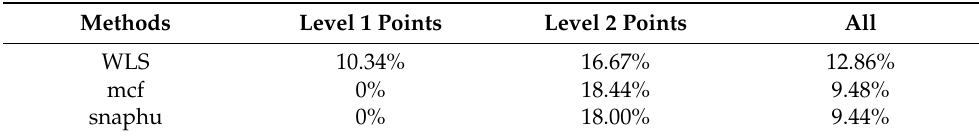
Figure 6. Comparison of unwrapping errors of different methods. Letters a, b, and c represent the WLS, mcf, and snaphu methods, respectively. Numbers 1–6 represent the unwrapping error of the first-level phase points without hierarchical networking, the unwrapping error of the first-level phase points with hierarchical networking, the unwrapping error of the second-level phase points without hierarchical networking, the unwrapping error of the second-level phase points with HNCA, the overall unwrapping error without hierarchical networking, and the overall unwrapping error with hierarchical unwrapping, respectively. Table 1. The RMSE of different unwrapping